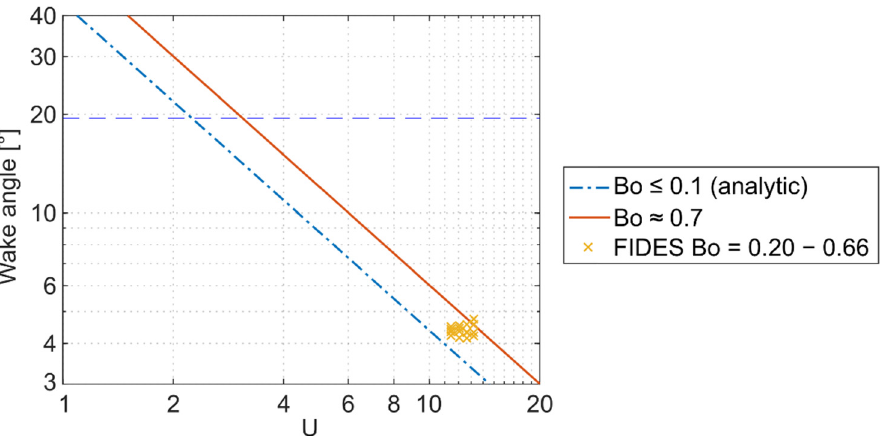
Figure 9. Wake angle plotted against velocity ratio U following Moisy and Rabaud [10]. The horizontal dashed line is the Kelvin angle 19.47 ◦ . The lower diagonal line is the wake angle curve corresponding to small Bond numbers ( Bo ≤ 0.1). The upper diagonal is a fit for Bo ≈ 0.7. Measured wake angles in FIDES are represented by the yellow crosses.